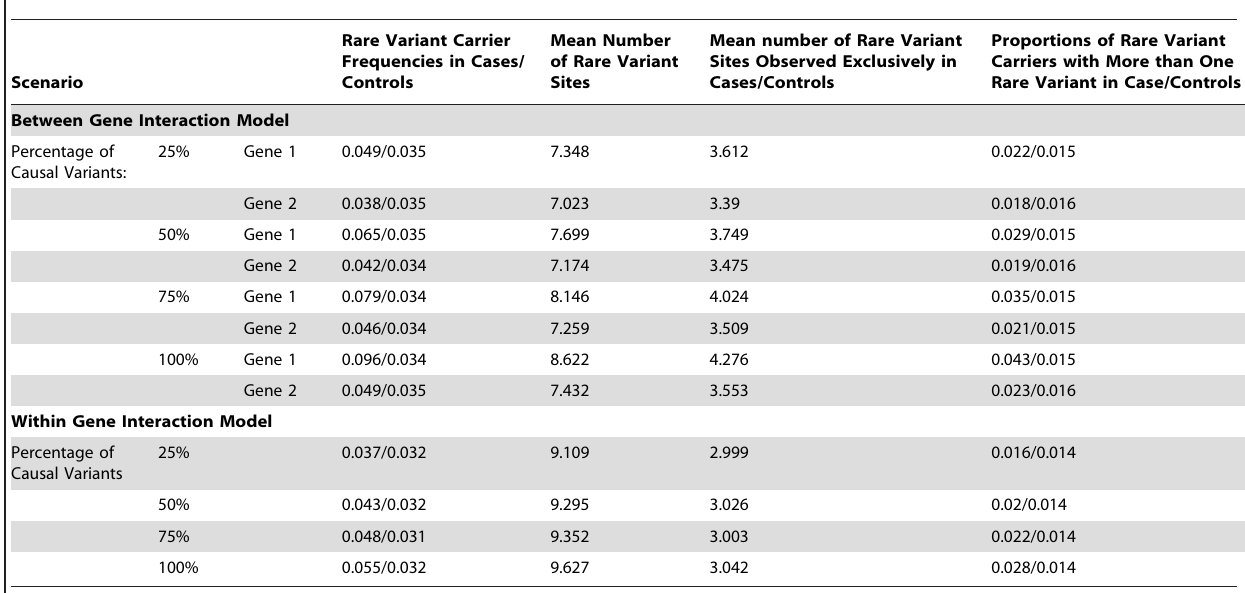
Table 2. Rare variant summary